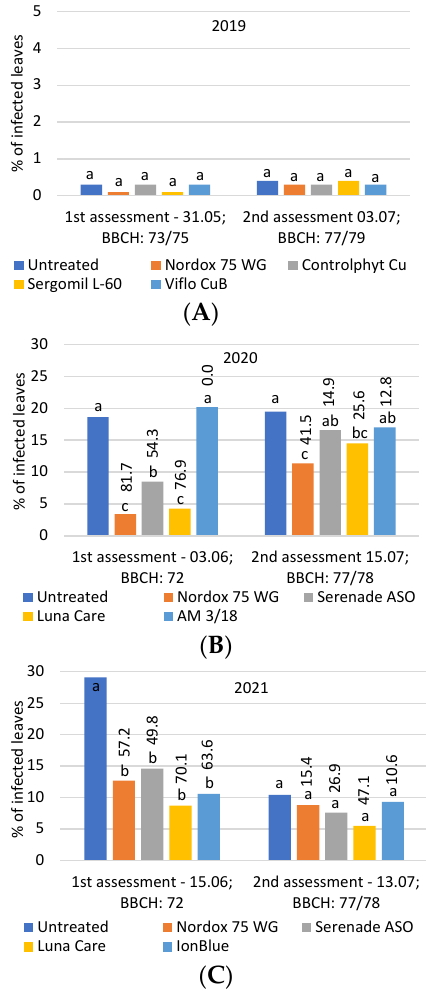
Figure 3. ( A – C ) Incidence Figure 4A–C. Incidence of infection by bacterial canker (caused by P. syringae ) on leaves of plum after foliar applications of different products during the flowering period in 2019–2021. Efficacy values are shown above each bar. The means marked by the same letter do not differ according to the Newman-Keuls test at the 5% significance level.